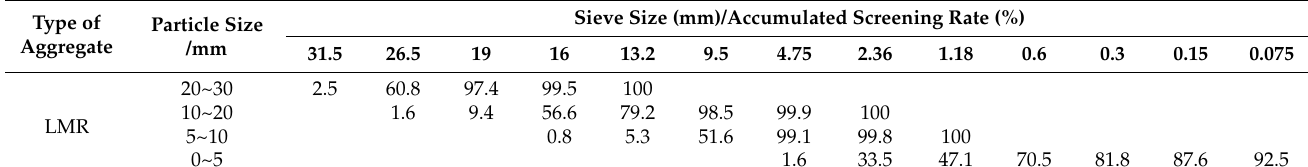
Table 3. The size distribution of LMR aggregates.